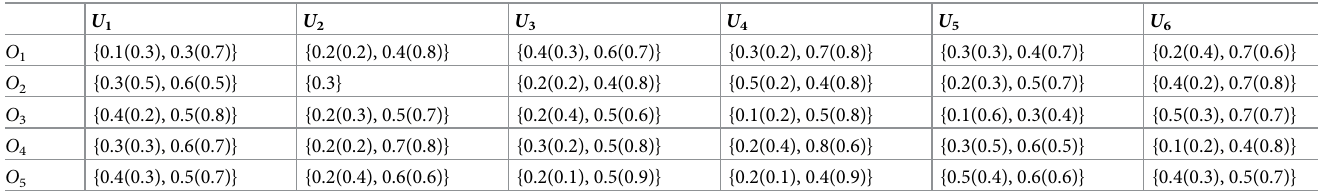
Table 2. PHF matrix R 2 given by the second